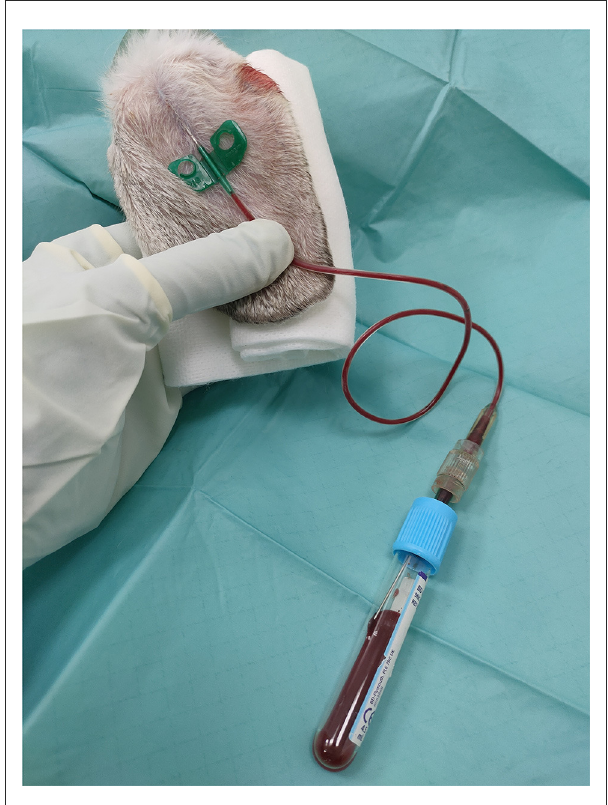
FIGURE1 Blood extraction from the auricular artery for PRGF obtention. A 21G Venofix connected to a 21G hypodermic needle by a male-male luer-lock connector was used for this purpose. The blood was collected in vacutainer sodium citrate 3.8% tubes.